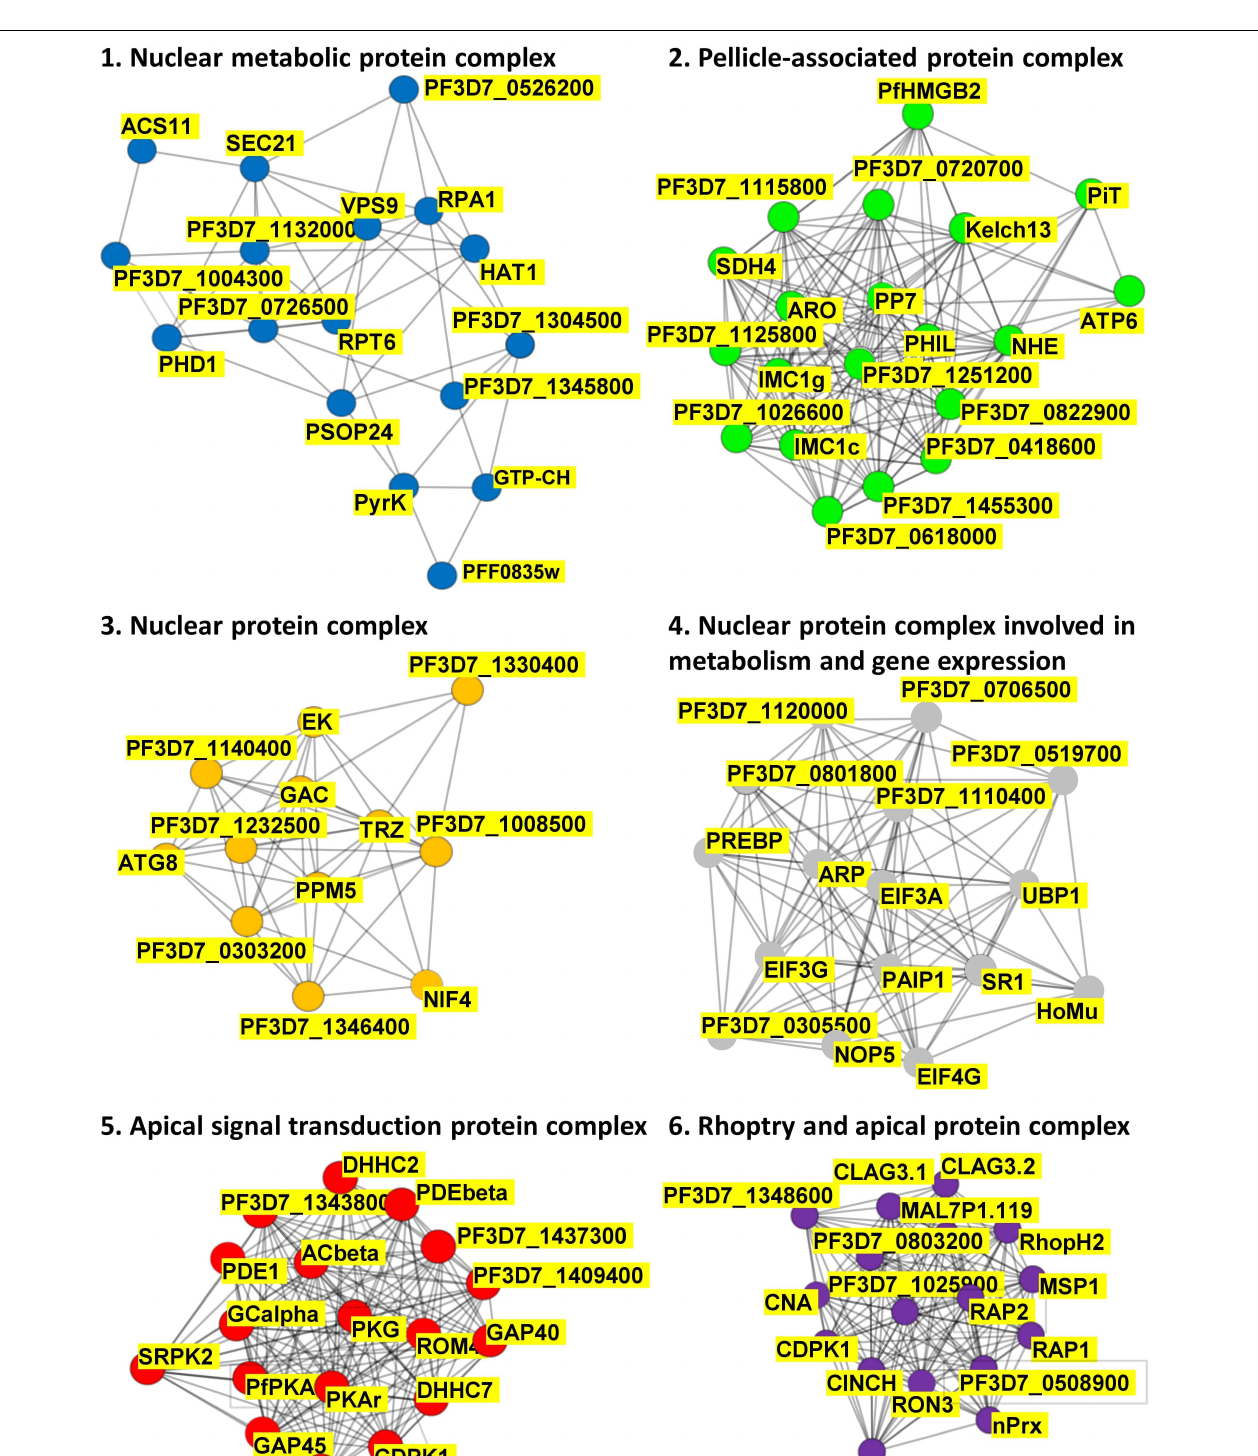
FIGURE 4 | PfPKA-mediated signaling protein interaction networks. Putative protein interaction networks associated with PfPKA signaling were generated by MCL clustering analysis of the PfPKA substrate interactome comprised of 109 proteins ( Supplementary Table 4 ) obtained from the STRING (https://string-db.org/) database of protein–protein interactions. Sub-networks were annotated functionally by Gene Ontology terms on the basis of frequency and enrichment.